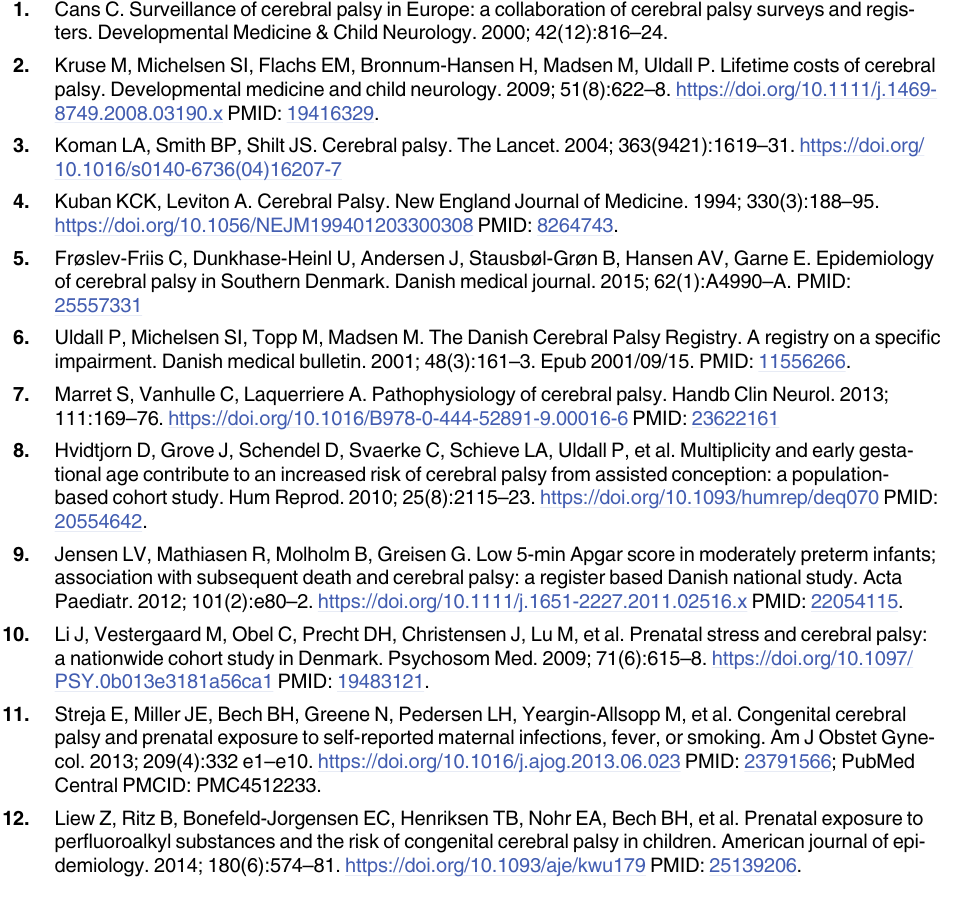
S3 Table. Association between maternal β 2AAs usage and cerebral palsy in female off- spring born at term by specific drugs. S4 Table. Association between maternal β 2AAs usage and cerebral palsy in female off- spring born at term restricted to subgroup with no maternal use of